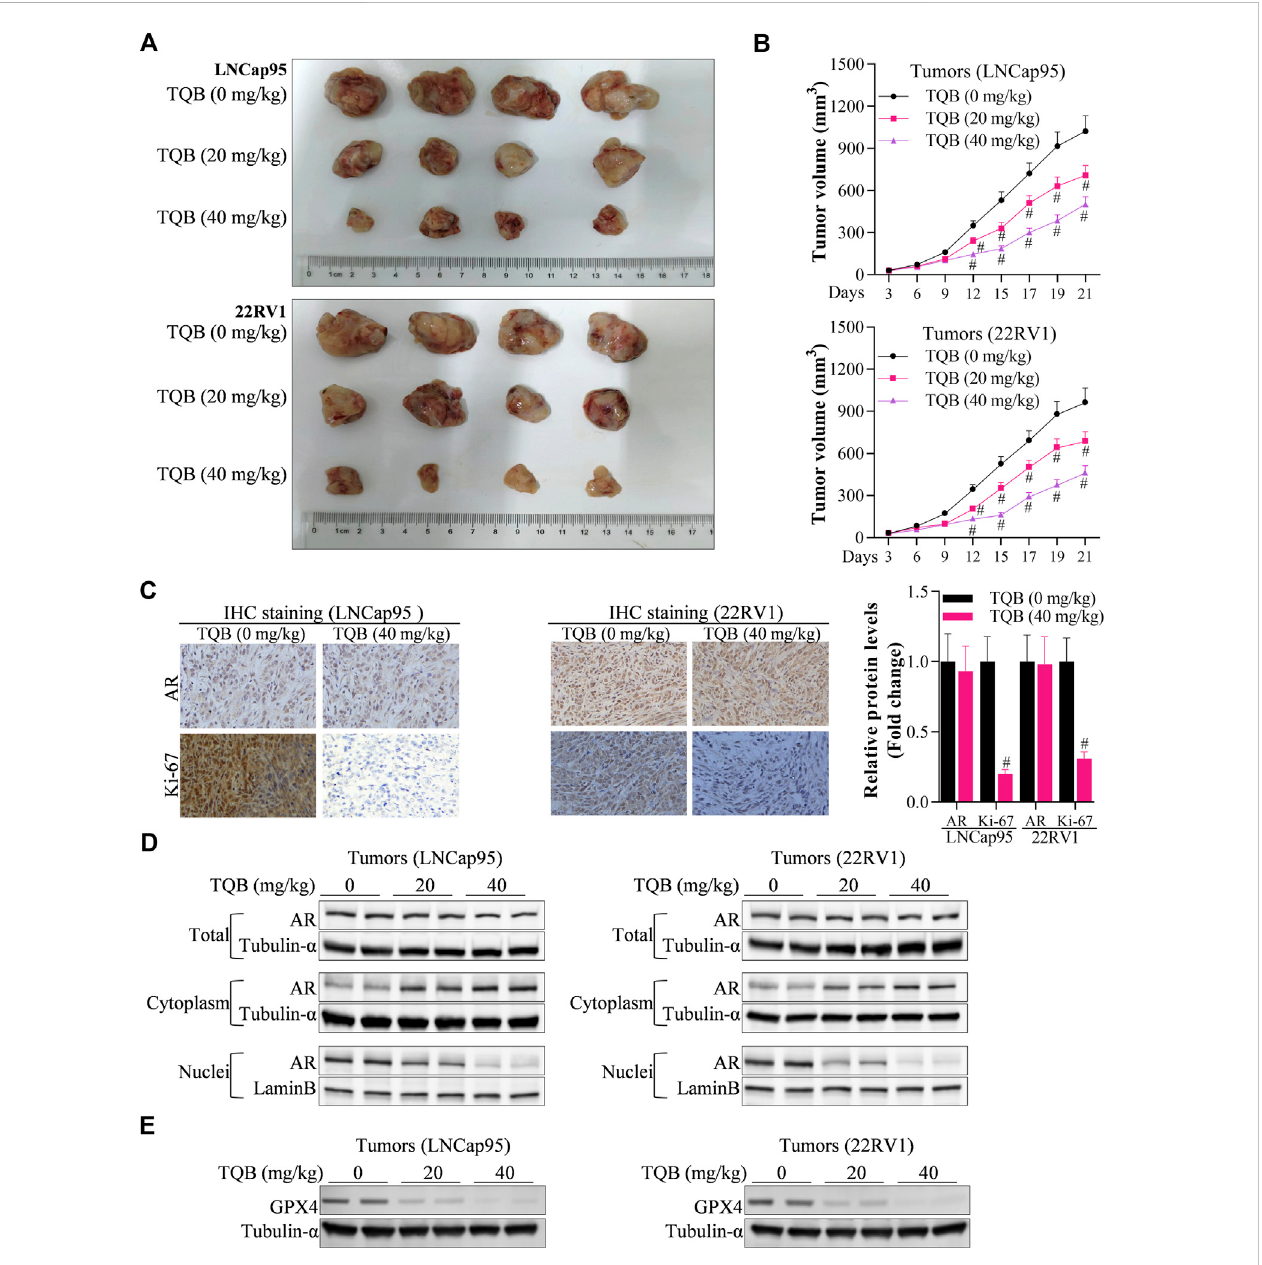
of AR proteins in the nucleus or cytoplasm tumors from nude mice. (E) Western blot examined the effects of TQB7320 on expression of GPX4 protein in